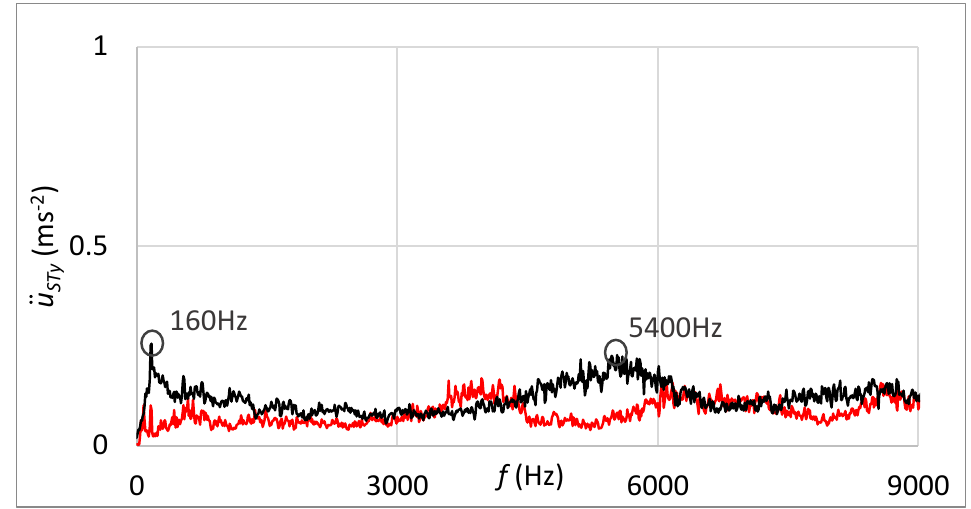
Figure 23. Frequency spectrum of vibrations with the sensor connection by the magnet; black—the damage of rolling elements; red—without the damage.